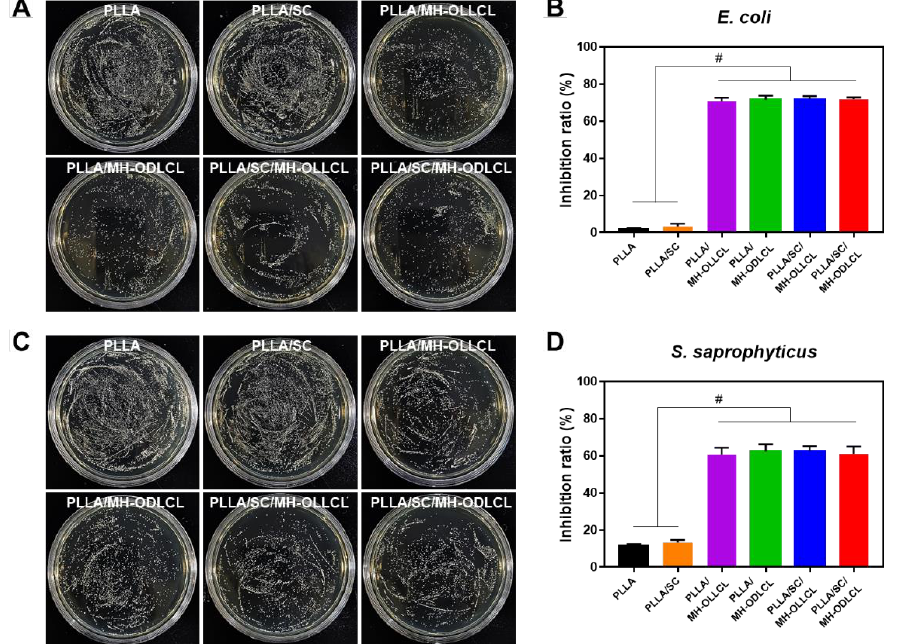
Figure 7. The bactericidal activity of each PLLA composite was investigated. Representative images showing the antimicrobial activities against Gram–negative bacteria ( E. coli ; A , B ) and Gram–positive bacteria ( S. saprophyticus ; C , D ) of the PLLA and the PLLA/SC, PLLA/MH–OLLCL, PLLA/MH– ODLCL, PLLA/SC/MH–OLLCL, and PLLA/SC/MH–ODLCL composites and their respective quantifications ( # p <